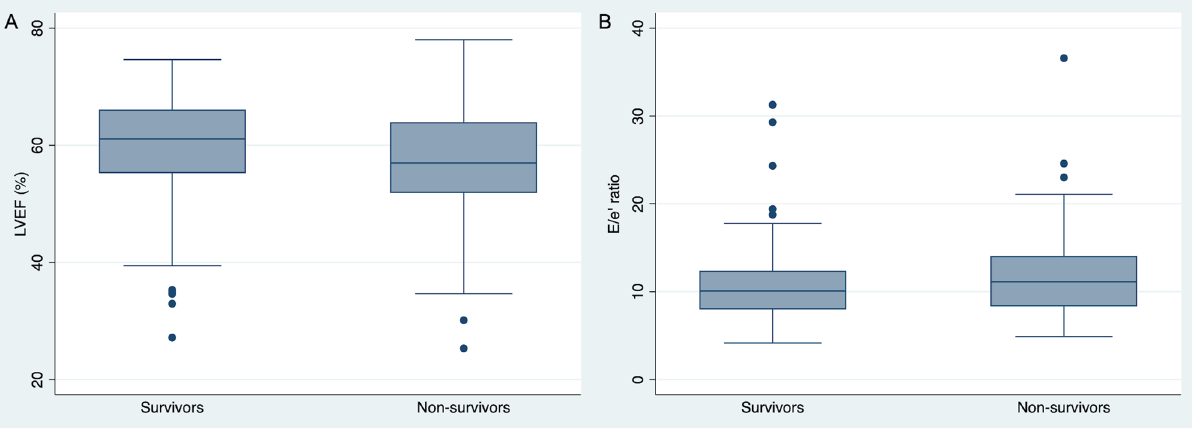
Figure 1. Differences in LVEF and E/e ′ between survivor and non-survivor patients with SARS-CoV-2 infection. LVEF ( A ) and E/e ′ ratio ( B ) distribution as box plots in survivor and non-survivor patients with SARS-CoV-2 infection. LVEF left ventricular ejection fraction.